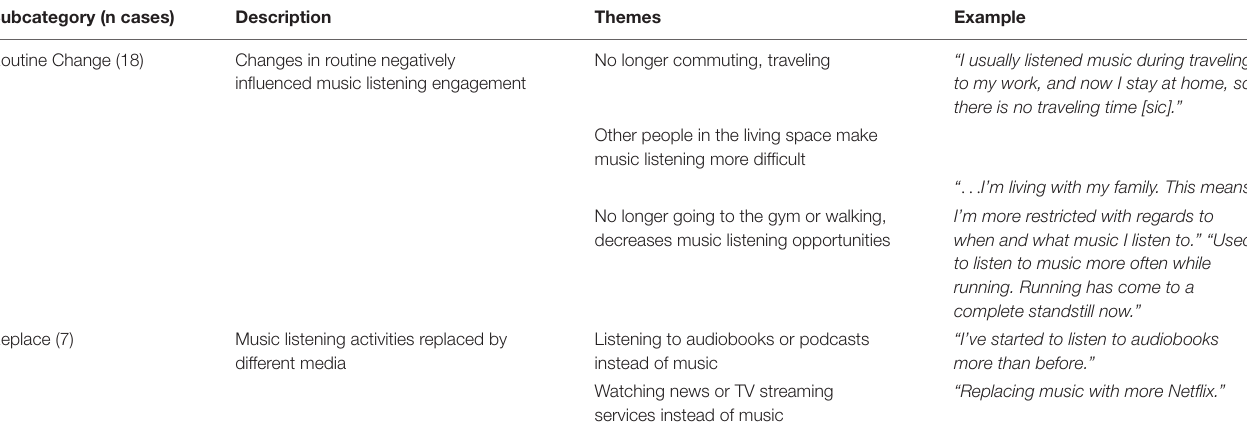
TABLE 4 | Subcategories related to Less